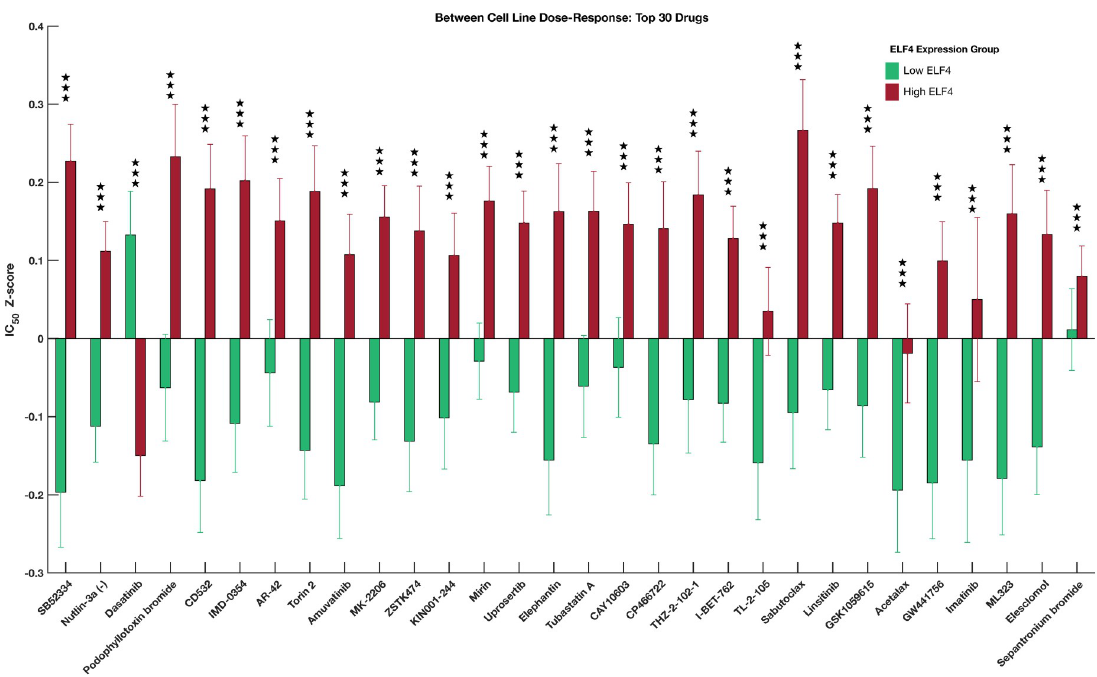
Fig 4. Top 30 drugs that showed the highest statistically significant dose-response differences between high-ELF4 cell lines and the low-ELF4 cell lines. The error bars show the standard error of the median logarithm IC50 value for each anti-cancer drug. The three stars show the degrees of statistical significance, i.e., p-values less than 0.001. For details, see S2